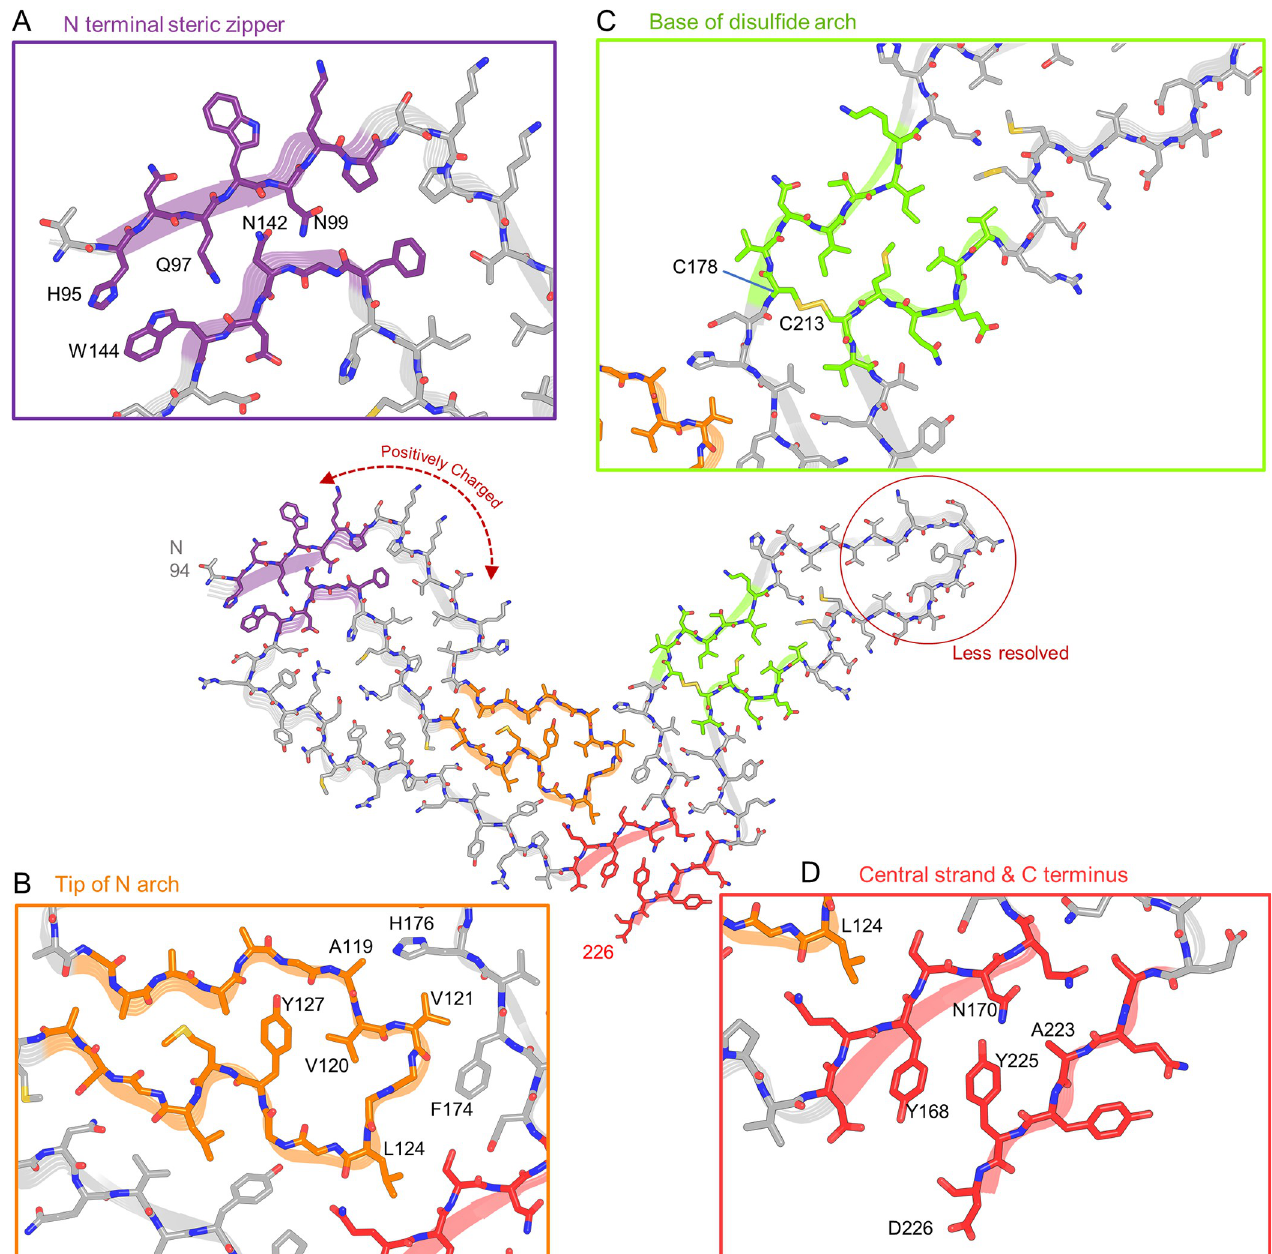
Fig 4. Features of the a22LL prion core. (A) Steric zipper (purple) is formed by the N-terminus (H95, Q97, N99) and tip of the middle arch (N142, W144). (B) Tip of the N arch (orange), as well as residues with which they interact across the central interface between the N- and C-terminal lobes. (C) Disulfide bond (C178 –C213) forms the base of disulfide arch (green) that is stabilized by a tight interface adjacent to a widening of the arch toward the tip (central model). The precise side-chain positions in the tip are less certain due to poorer resolution in that portion of the cryo-EM density map (see Fig 2D). (D) Steric zipper (red) between a central β -strand and C-terminus. “Positively charged” indicates a span of mostly basic residues that includes four lysines and a histidine.